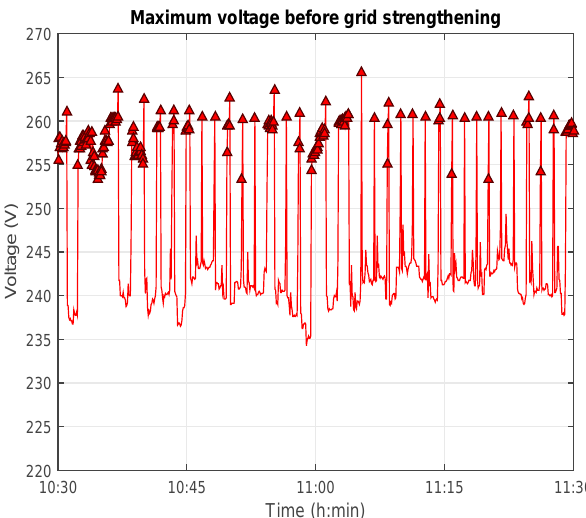
Figure 4. Maximum voltage behavior before the grid strengthening during one hour. Swells are marked with red upwards ‐ pointing triangles.